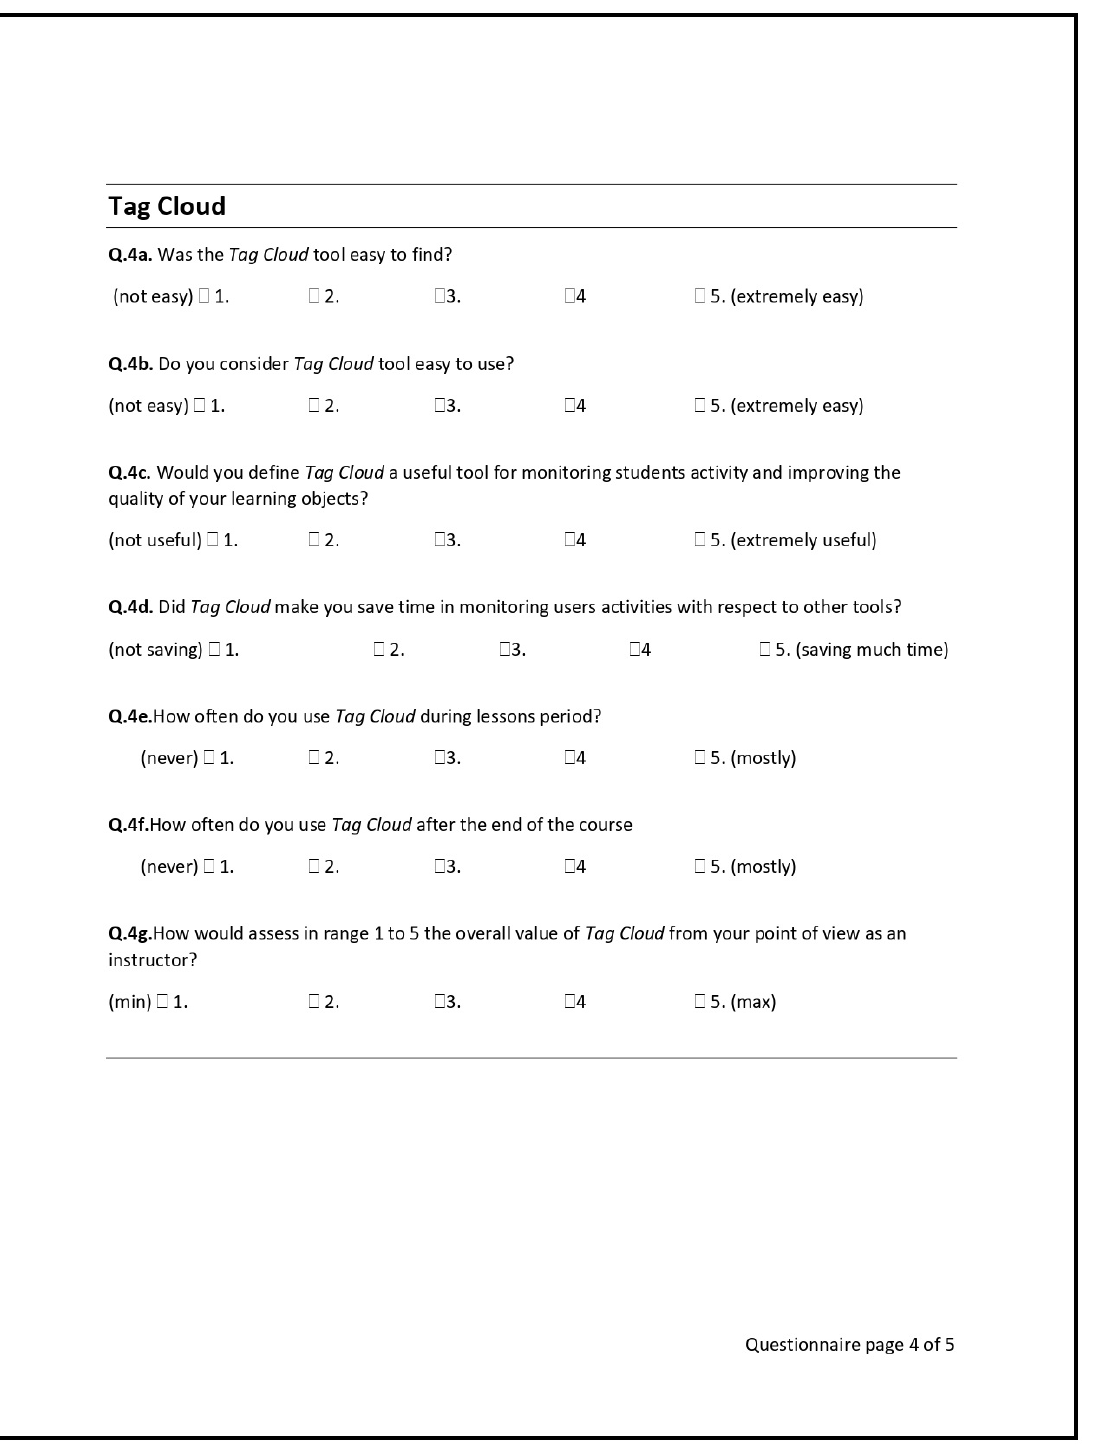
Figure A4. Questionnaire page 4 of